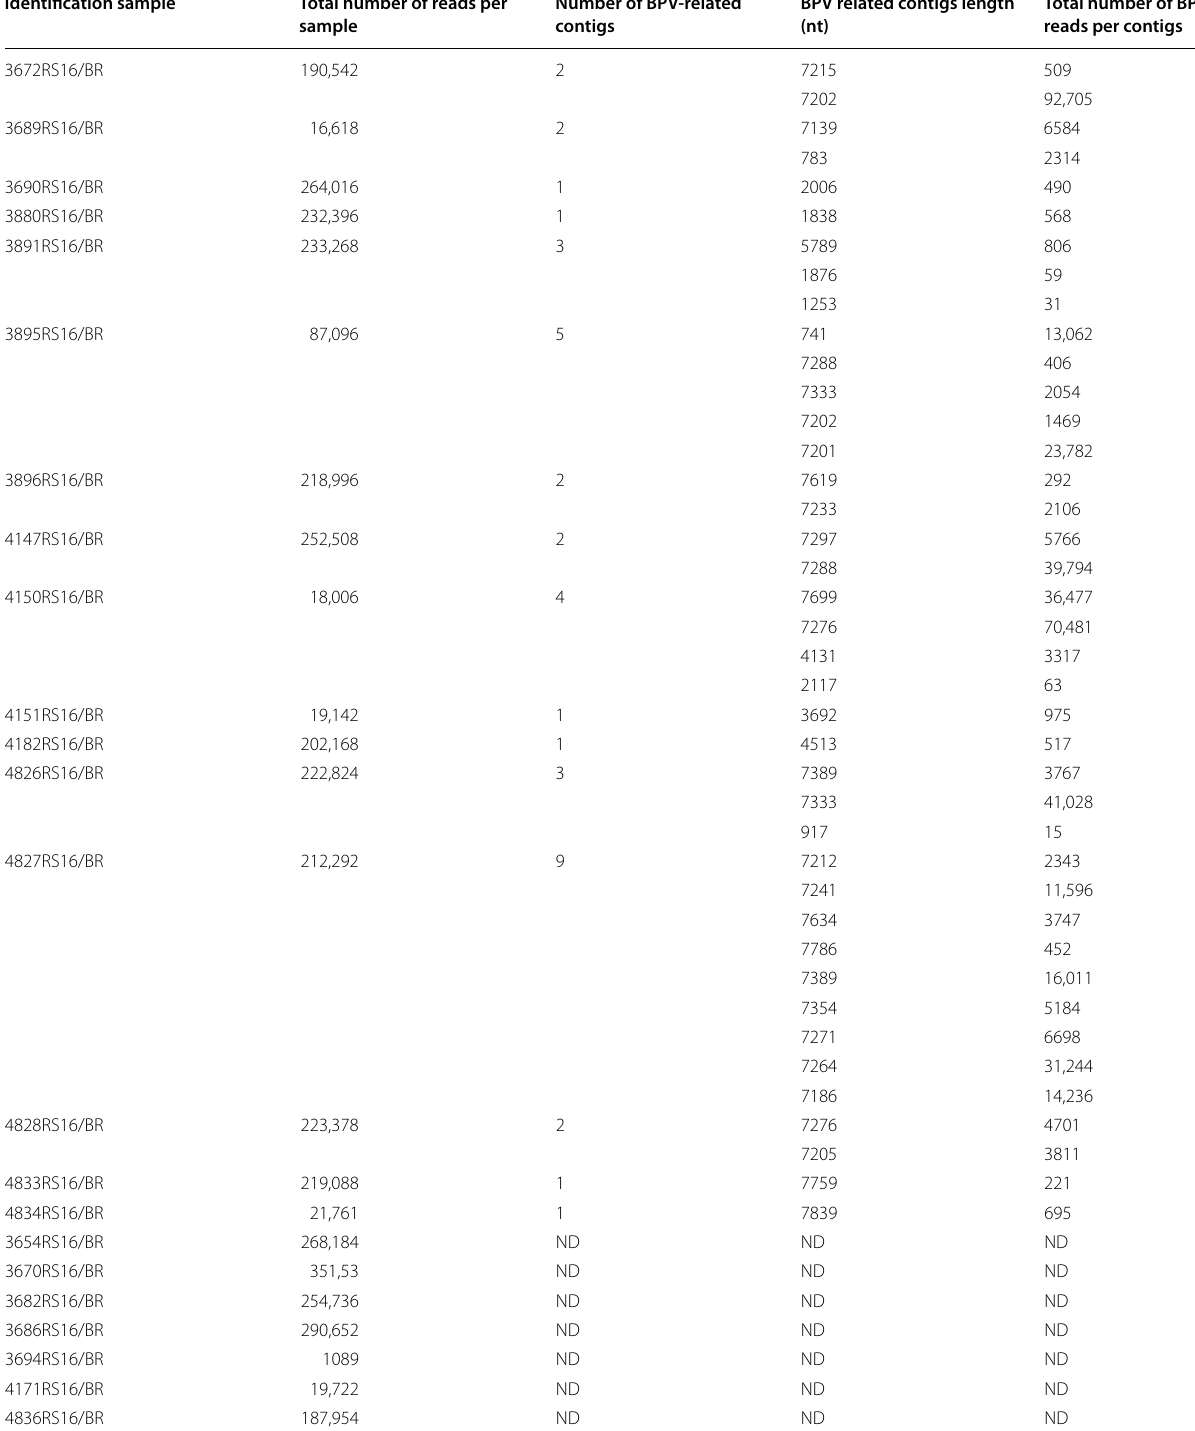
Table 1 Overview of HTS results from the samples of this